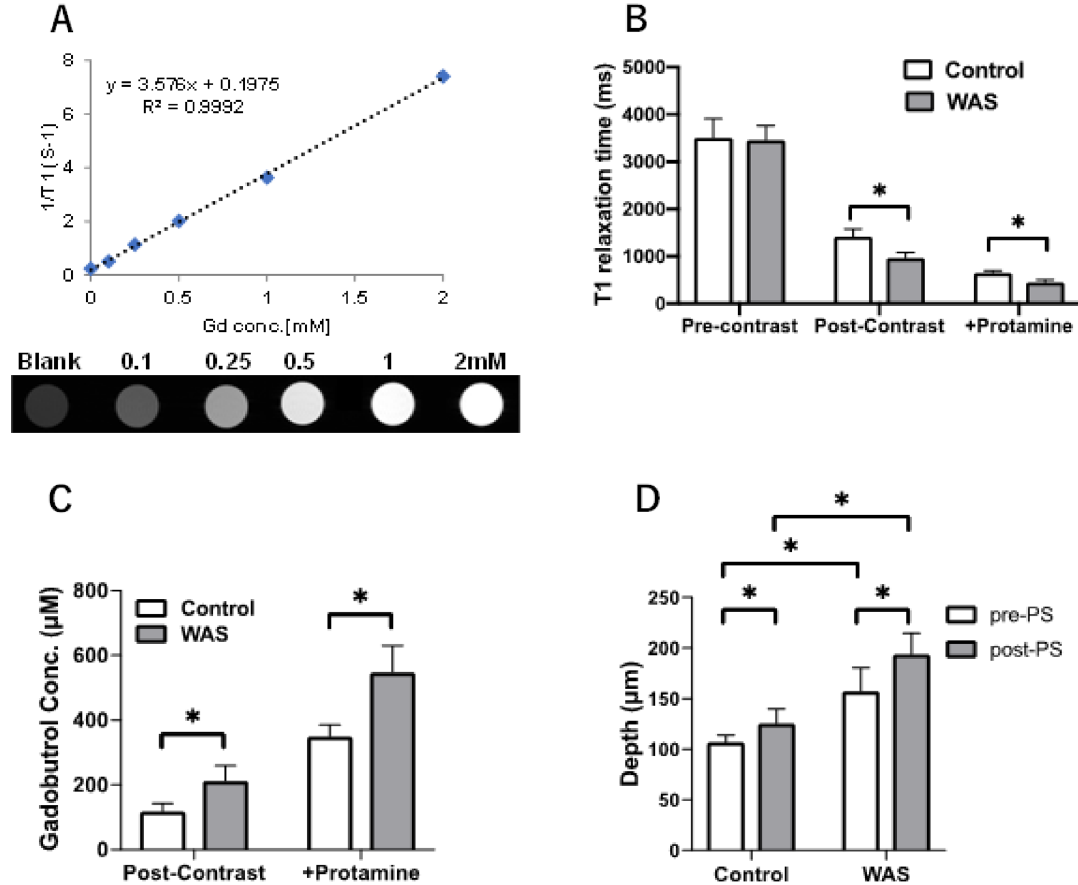
Figure 2. Gadobutrol Permeability Derived from Voxel-wise T 1 mapping: ( A ) To derive the Gadobutrol concentration [Gd] in the bladder mucosa using the Eq. (1), we first estimated the T 1 relaxation rate constant or relaxivity ( r 1 ) of Gadobutrol at 9.4 T by the linear fitting of the reciprocal of the water T 1 relaxation time or T 1 water relaxation rate (1/T 1 ) measured in the serial two fold dilutions of [Gd] 2 mM at 37 °C. Linear fitting generated the regression equation: y = 3.576x + 0.1975 with the coefficient of determination (R 2 ) of 0.999 and r 1 value of 3.576 L/mmol/s for Gadobutrol at 9.4 T. In contrast to the linear relationship between T 1 water relaxation rate of the phosphate buffered saline (PBS) vial (blank) supplemented with ascending concentrations of Gadobutrol from 0.1-2 mM [Gd], the non-linearity between [Gd] and signal intensity is illustrated by the doubling of [Gd] from 1 to 2 mM producing only a minor change in the signal intensity of T 1 weighted